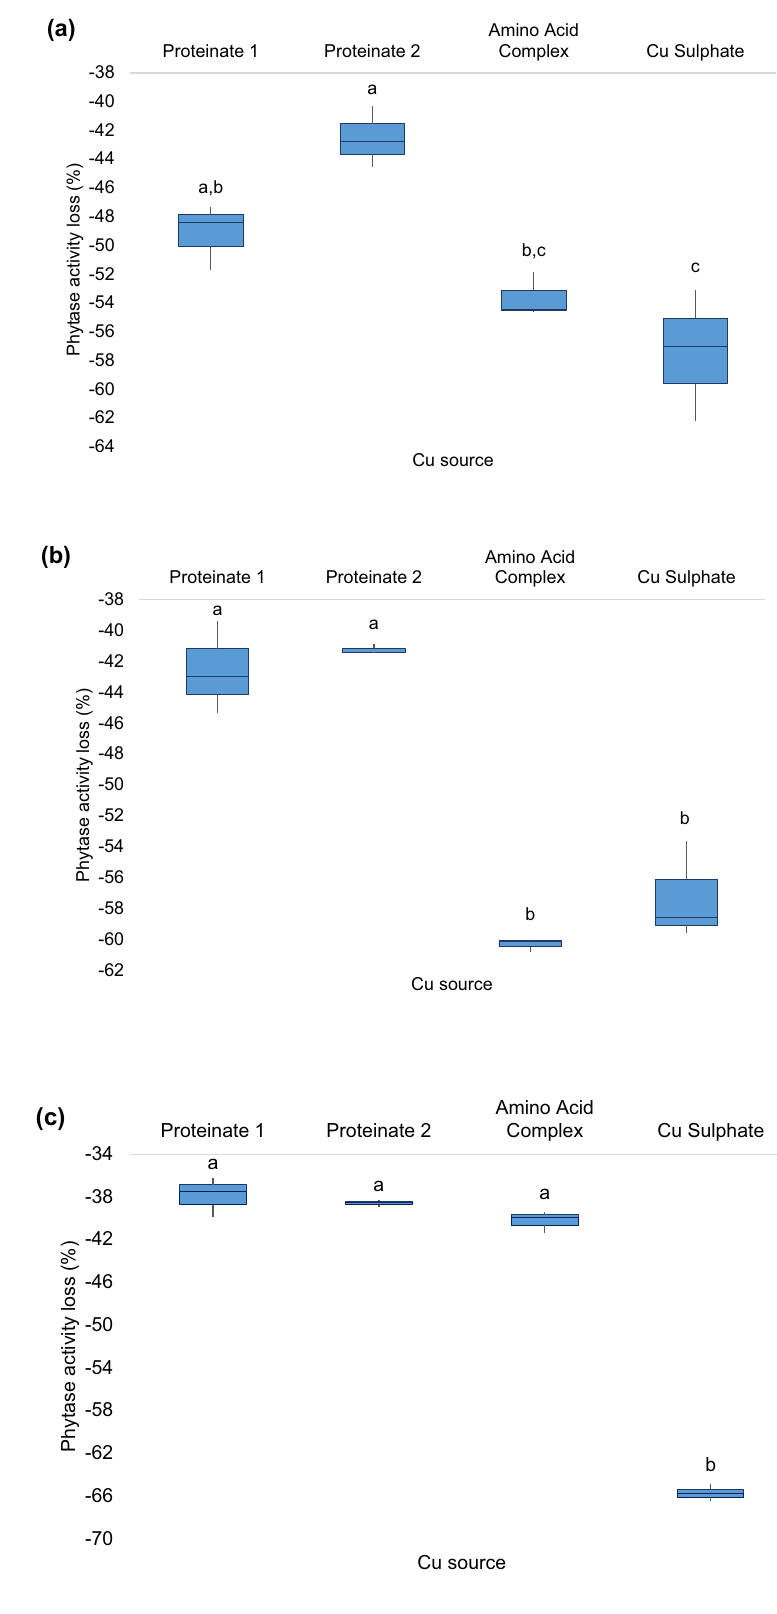
Fig. 3 Phytase activity loss of a Phy 1, b Phy 2 and c Phy 3 after exposure to different Cu sources. Data are a means of triplicate experiments. Aver- age values lacking a common superscript differ in statistical significance according to one- way ANOVA and separation by Tukey’s test ( p ≤ 0.05).